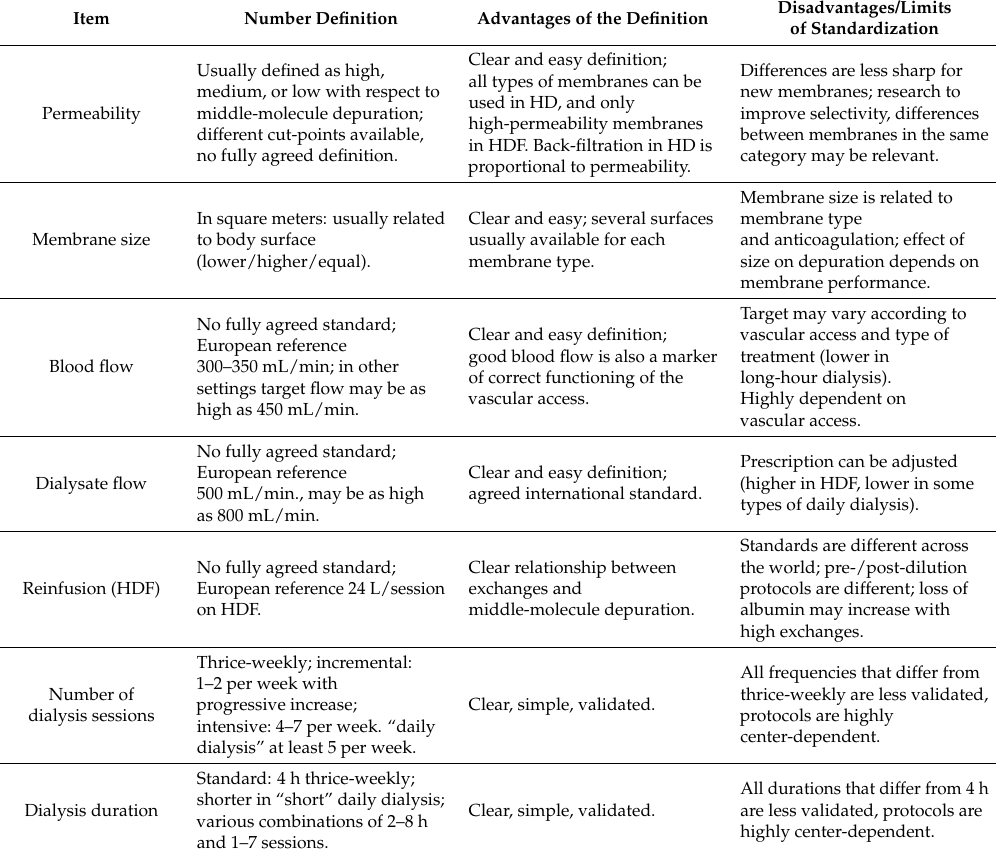
“Magic number” definitions and limits: hemodialysis (HD) and hemodiafiltration (HDF)